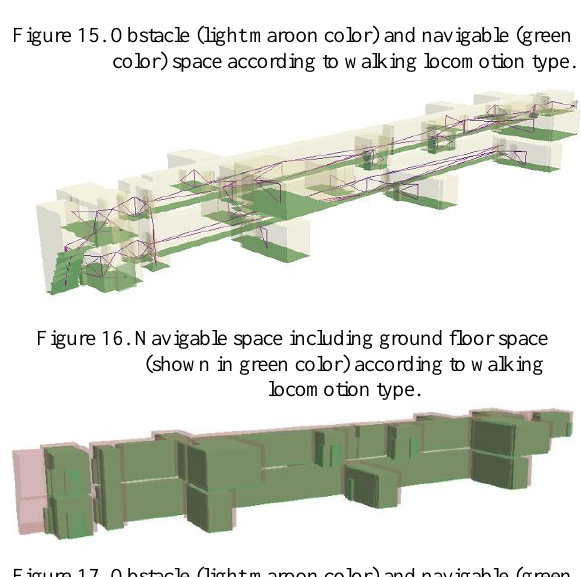
Figure 17. Obstacle (light maroon color) and navigable (green color) space according to driving locomotion type.